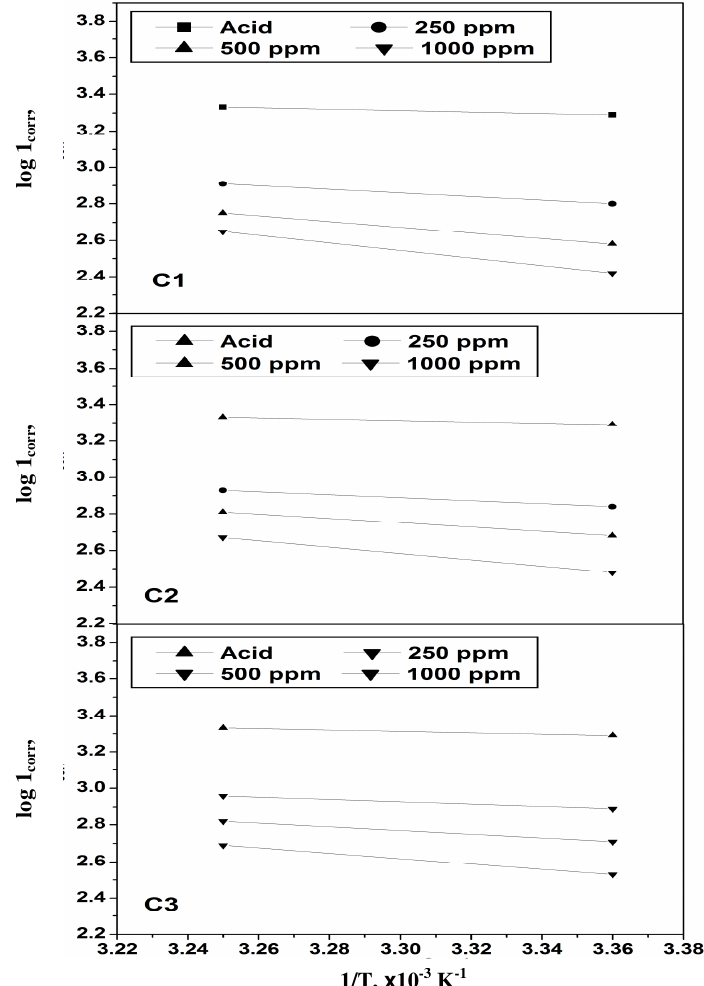
Figure 4. Variation of corrosion current with temperature at different concentration of inhibitors in 0.5 N